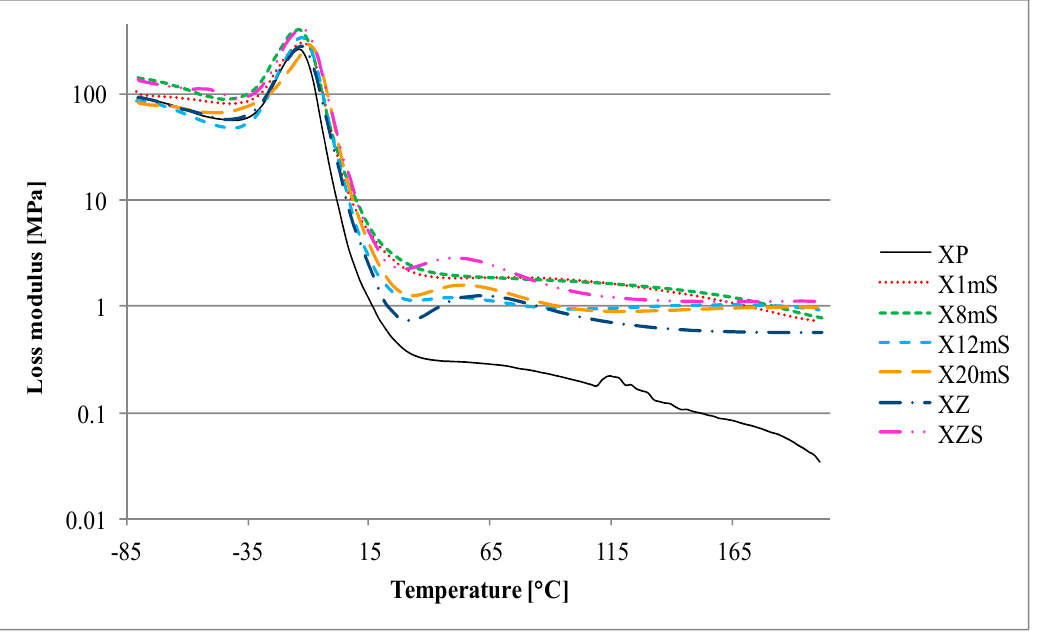
Figure 2. The temperature ( T ) dependency of loss modulus ( E” ) at 5 Hz for XNBR vulcanizates.